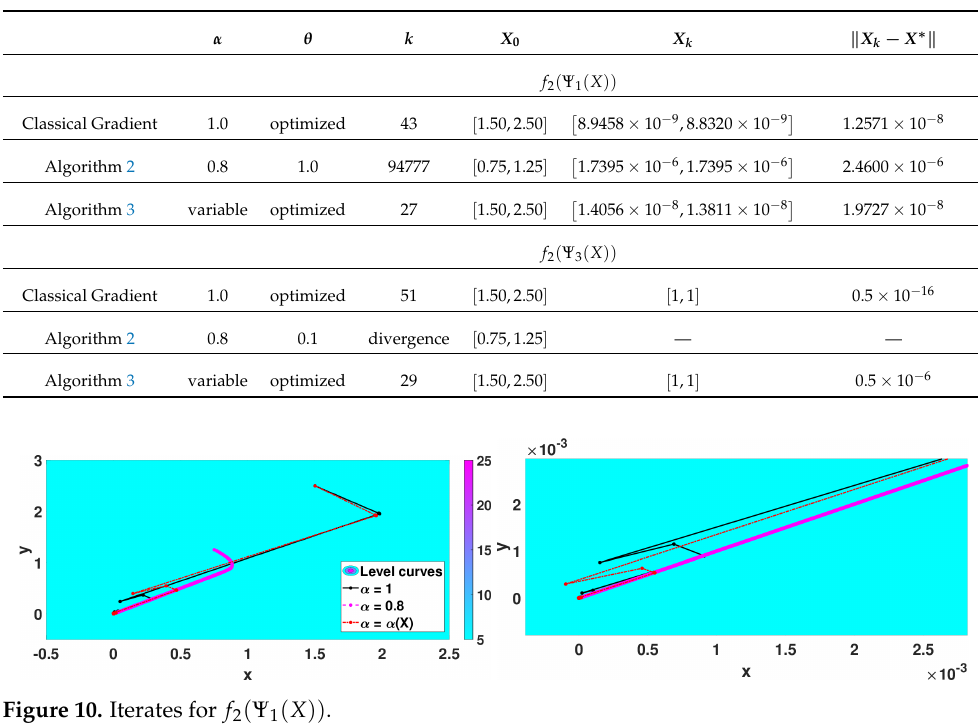
Table 2. Information about the k -iteration associated with Figures 10 and 11.